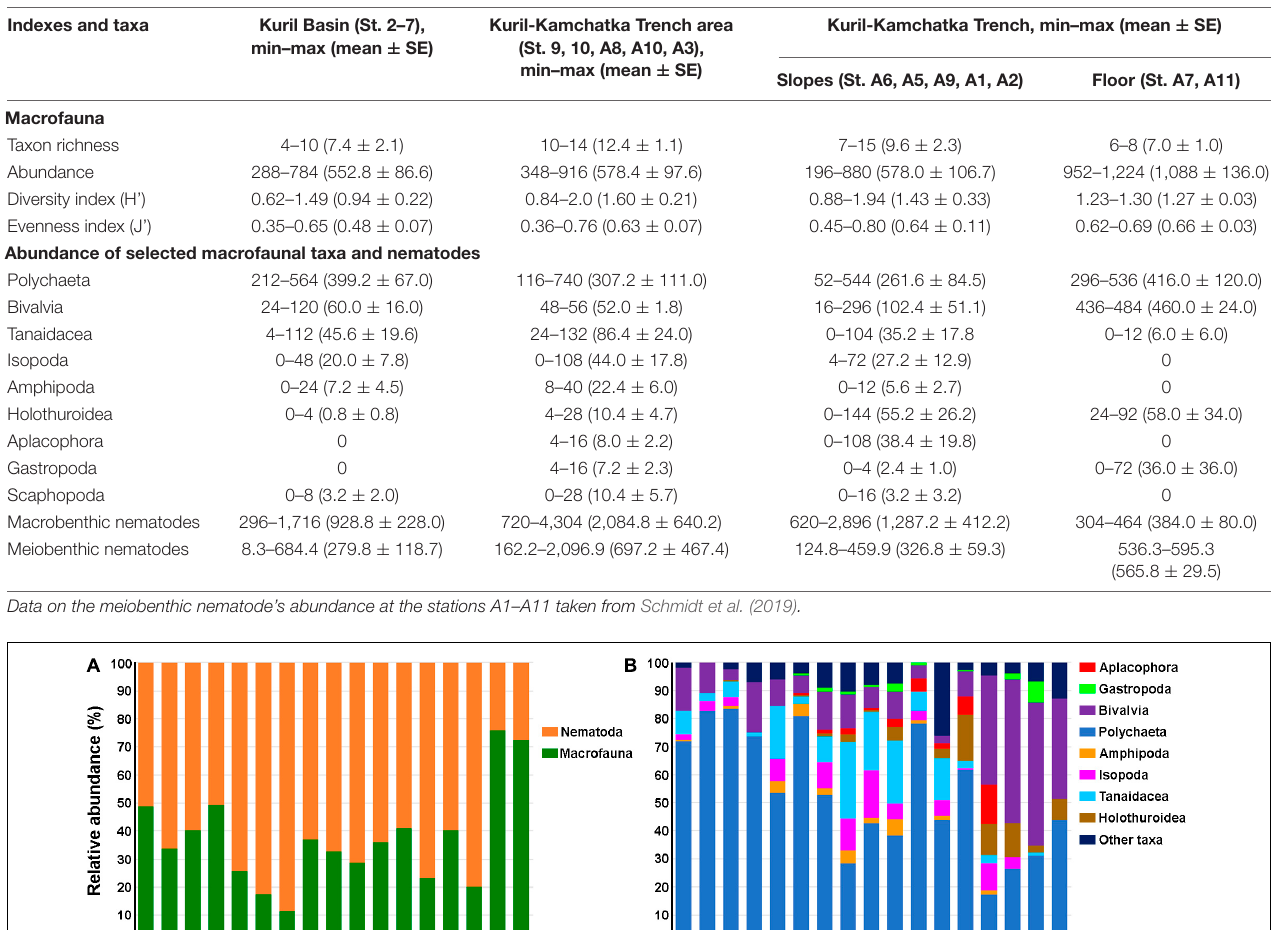
TABLE 3 | Taxon richness (number taxa per sample), abundance (ind. m − 2 ), and diversity indexes of macrofauna and abundance of selected macrofaunal taxa (ind. m − 2 ), macro- (ind. m − 2 ) and meiobenthic (ind. 10 cm − 2 ) nematodes from the quantitative samples collected in the abyssal zone (3,300–3,366 m) of the Kuril Basin (Sea of Okhotsk), abyssal zone (3,432–5,741 m) of the Kuril-Kamchatka Trench area, and hadal zone (6,068–9,539 m) of the Kuril-Kamchatka